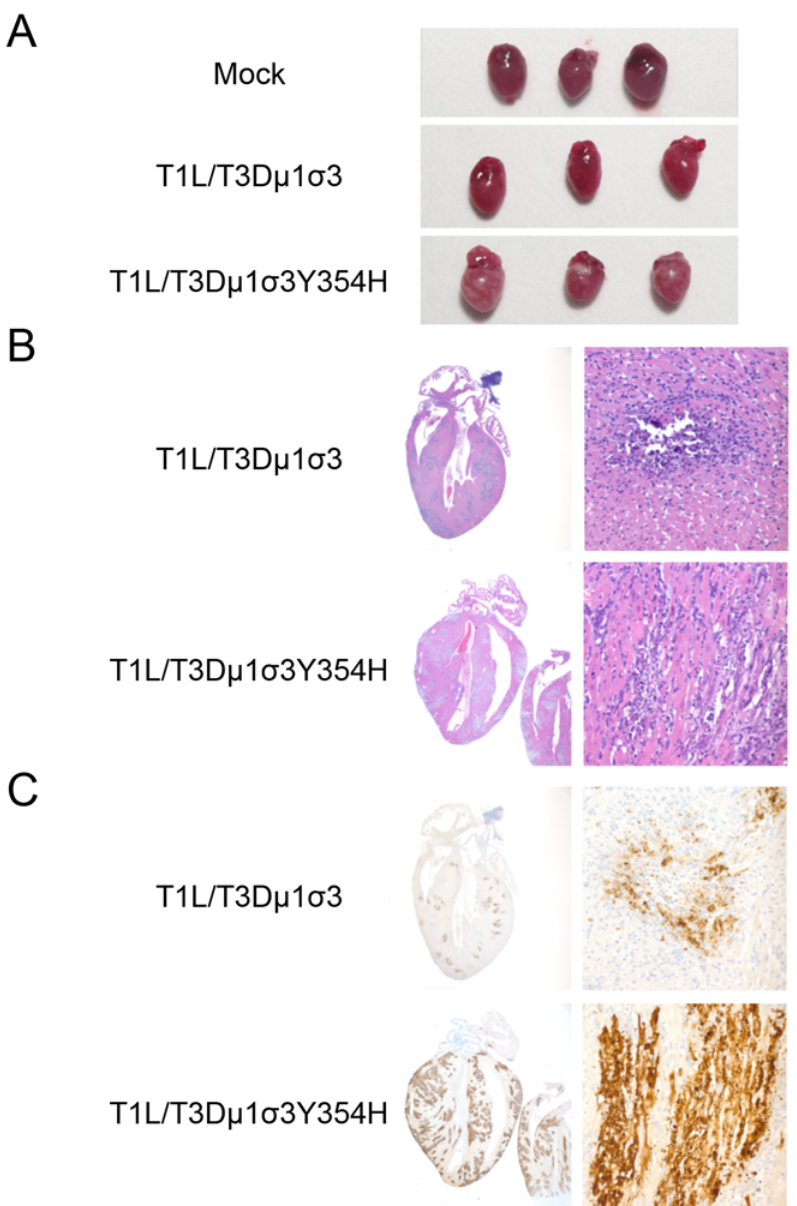
Fig 6. Reovirus strain T1L/T3D μ 1 σ 3Y354H causes pronounced myocarditis. Newborn C57BL/6J mice were inoculated perorally with 10 3 PFU of either T1L/T3D μ 1 σ 3 or T1L/T3D μ 1 σ 3Y354H. On day 8 post- inoculation, mice were euthanized, and hearts were excised and photographed (A). Cardiac tissue was fixed in formalin, embedded in paraffin, sectioned, and stained with H&E (B) or reovirus-specific polyclonal antiserum (C). Images are shown at 20X (left) and 400X (right)